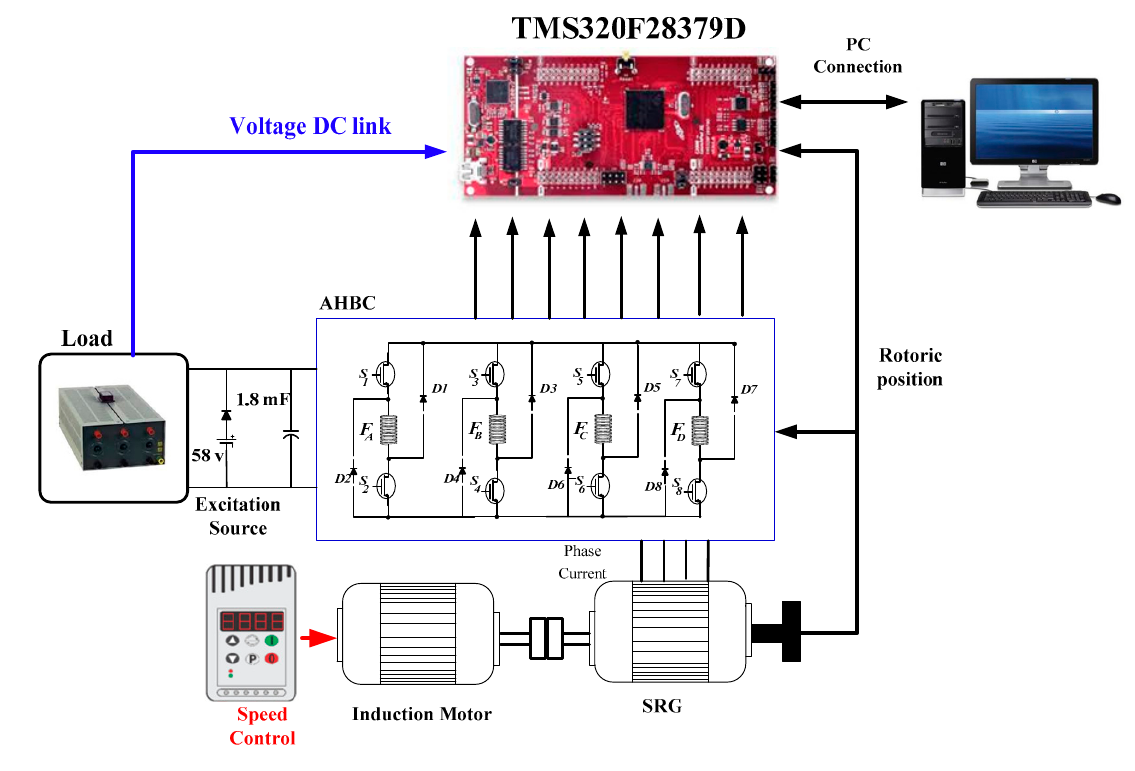
Figure 11. Experimental test bench.